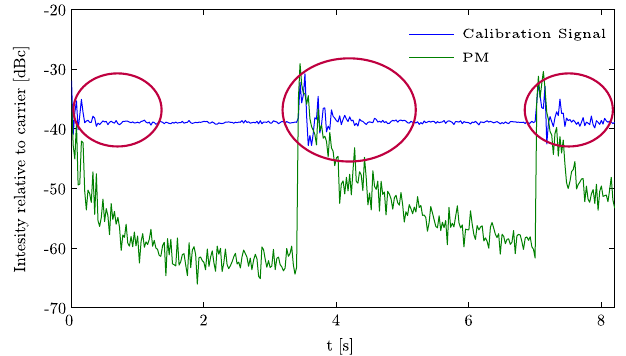
FIG. 7. Graph of the calibration signal after phase demodula- tion. The red circles show an interval, after which the measured signal can be considered reliable, since no saturation effects in the electronic chain are indicated. The data were taken with the nominal LHC 25 ns beam of four batches at SPS flat bottom.